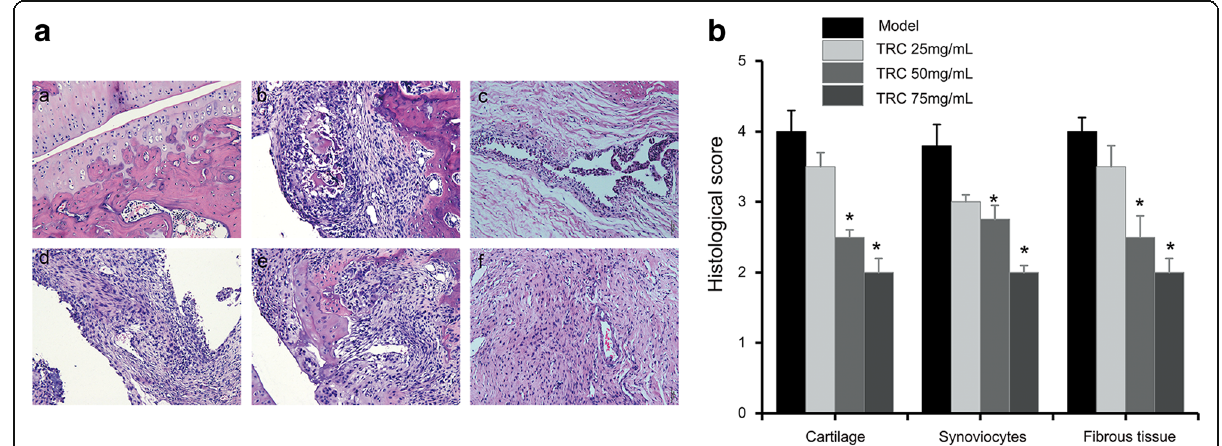
Fig. 5 Haematoxylin and eosin staining of the ankle joints in CIA rats. a HE (100×). b The histological score of cartilage damage, synoviocytes, fibrous tissue in ankle joint of CIA